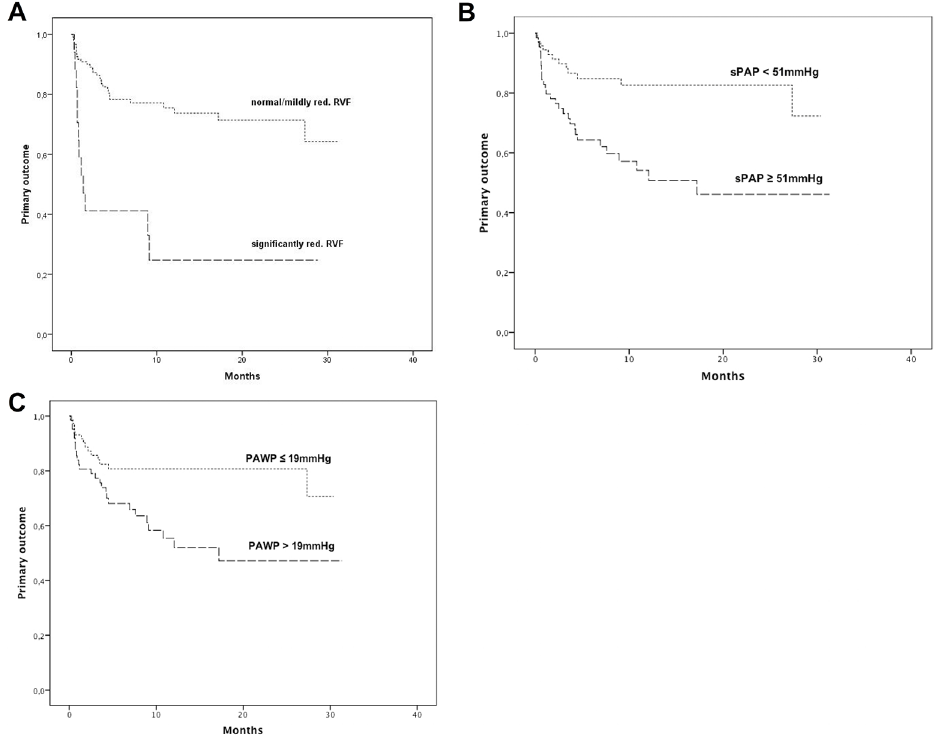
Fig 1. Kaplan-Meier estimates of primary endpoint (hospitalization for heart failure and/or death for cardiac reason) according to echocardiographic right ventricular function (normal and mildly reduced vs. significantly reduced. 3A; P < 0.001, log-rank test), according to invasively measured systolic pulmonary arterial pressure (3B; cut-off = median; P = 0.001, log-rank test), and according to pulmonary artery wedge pressure (3C; cut-off = median; P = 0.006; log-rank